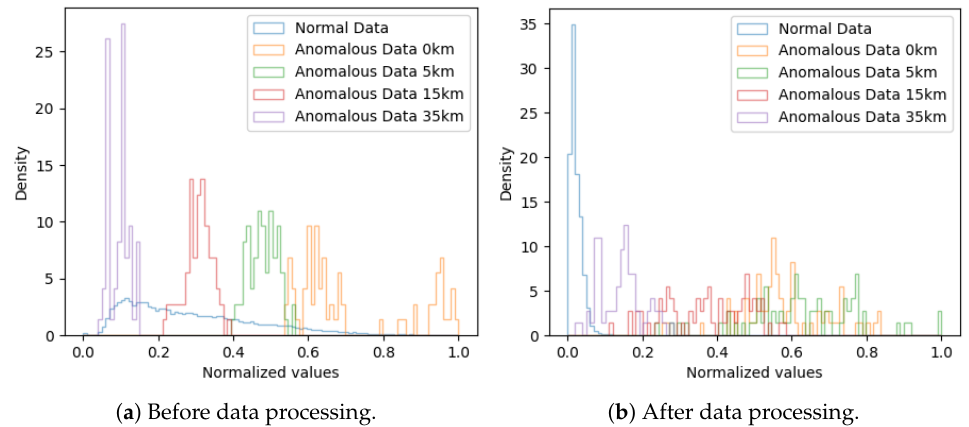
Figure 8. Comparison of histograms before and after processing the data through our system for Hydraulic